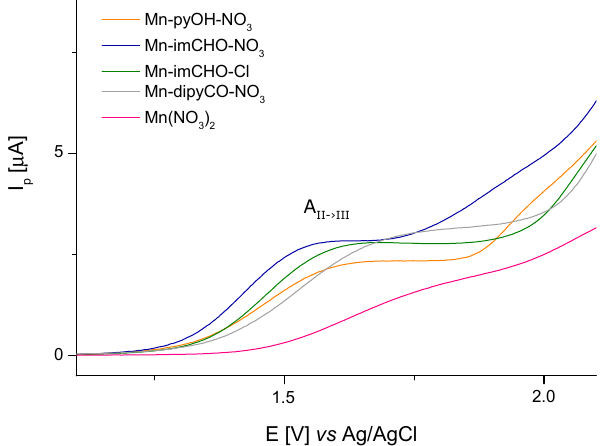
Figure 7. The voltametric curves (V = 6.25 mV s − 1 ) showing the comparison of the anodic peaks related to oxidation of Mn(II)/Mn(III) for Mn-pyOH-NO 3 , Mn-imCHO-NO 3 , Mn-imCHO-Cl, and Mn-dipyCO-NO 3 .